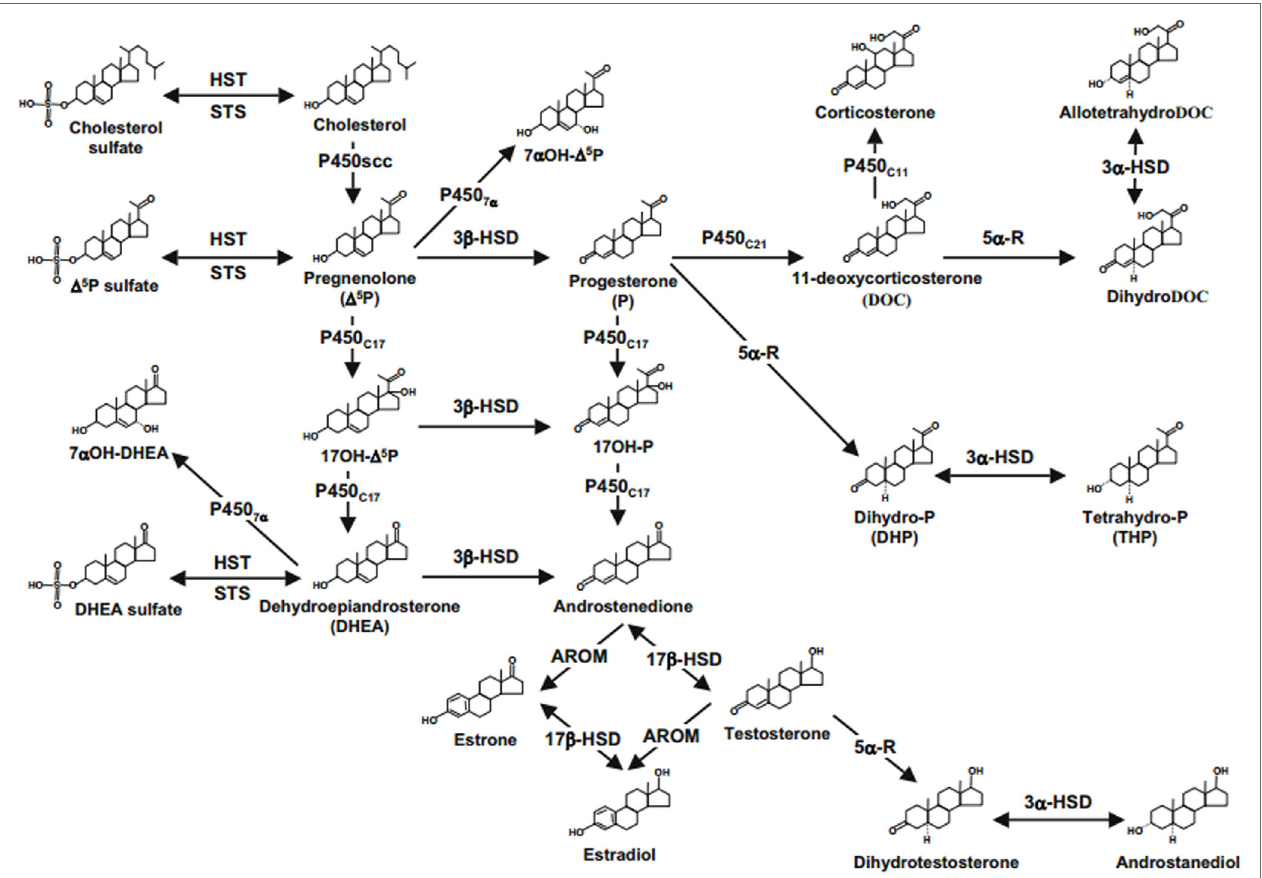
FiGURe 1 | Neurosteroids biosynthesis in the central nervous system. Abbreviations: 17b-HSD, 17b-hydroxysteroid dehydrogenase; 3a-HSD, 3a-hydroxysteroid dehydrogenase; 3b-HSD, 3b-hydroxysteroid dehydrogenase; 5a-R, 5a-reductase; AROM, aromatase; HST, sulfotransferase; P4507a, cytochrome 7a-hydroxylase; P450C11b,11b-hydroxylase; P450C17, cytochrome P450 17a-hydroxylase/C17,20-lyase; P450C21, 21-hydroxylase; P450scc, cytochrome P450 side-chain cleavage; STS, sulfatase (2, 22,